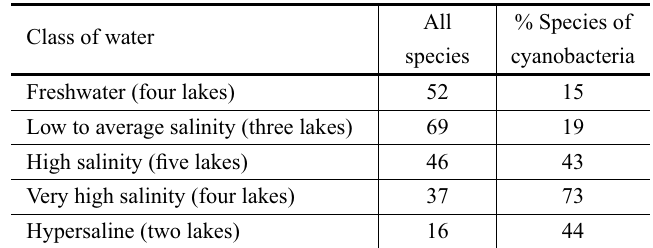
Number of species of phytoplanktonic organisms observed in the lake samples from the Rio Negro farm and the relative percentage of cyanobacteria. Sampling was done in August 2007.